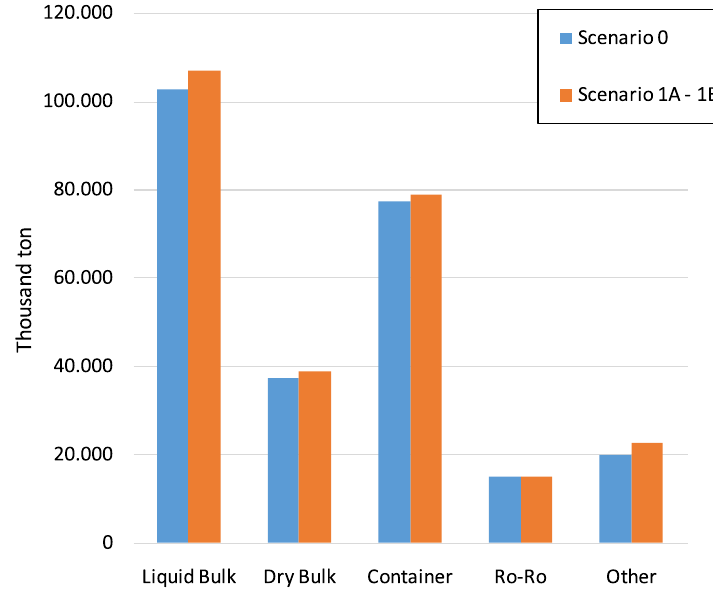
Fig. 5 Scenario comparison of traffic